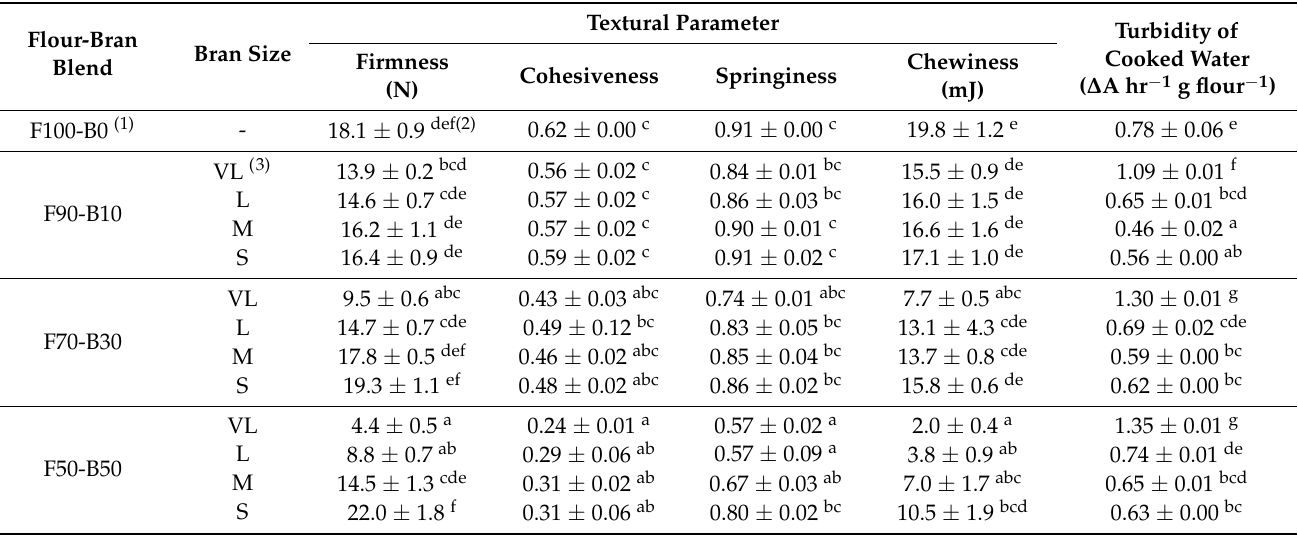
Table 6. Textural parameters of cooked noodles prepared from flour alone and flour-bran blends with different bran sizes and blend